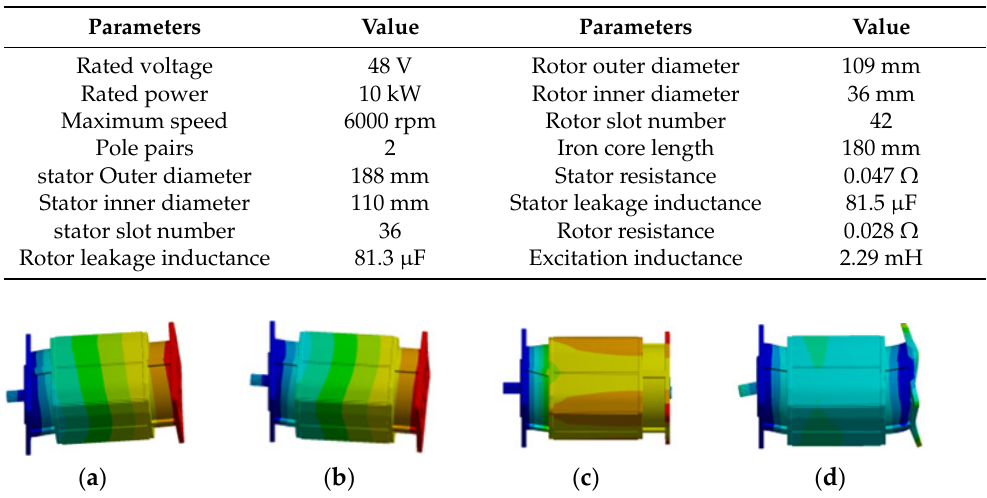
Figure 2. Simulation of the IM natural frequency. ( a ) 1st order modal; ( b ) 2nd order modal; ( c ) 3rd order modal; and ( d ) 4th order modal. Table 1. The parameters of the IM.